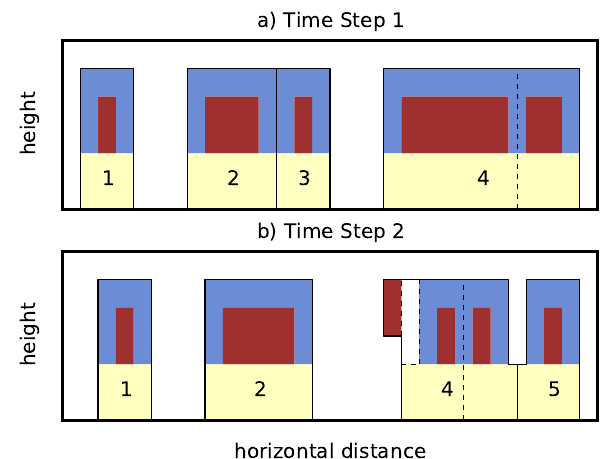
Fig. 3. Example of possible relationships between clusters and cloudlets at successive time steps. Top panel represents a vertical model section showing 4 clusters being tracked by the algorithm. Bottom panel represents the same vertical model section 1 min later. As in Fig. 1, cloud core is dark red, condensed liquid water is blue, and the tracer plume is light yellow. Solid black lines denote clus- ters, and dashed lines show the cloudlets that compose these clus- ters. The left side of the sections shows cloudlet 1 unambiguously overlapping cluster 1. The middle of the sections shows two clus- ters merging; in the first time step, the clusters’ condensed regions have come into contact, but not until their core regions form a sin- gle contiguous area does cluster 3 merge with cluster 2. The right side of the sections shows a cluster splitting in two. Initially, cluster 4 is composed of two cloudlets with connected condensed regions. At the next time step cluster 5 splits from cluster 4 since their con- densed regions have separated and cluster 5’s cloudlet has a plume in contact with the ground. The disconnected core cloudlet on the left side of cluster 4 does not split since it has no plume connection to ground. The remaining two cloudlets which compose the bulk of cluster 4 do not split since their condensed regions are